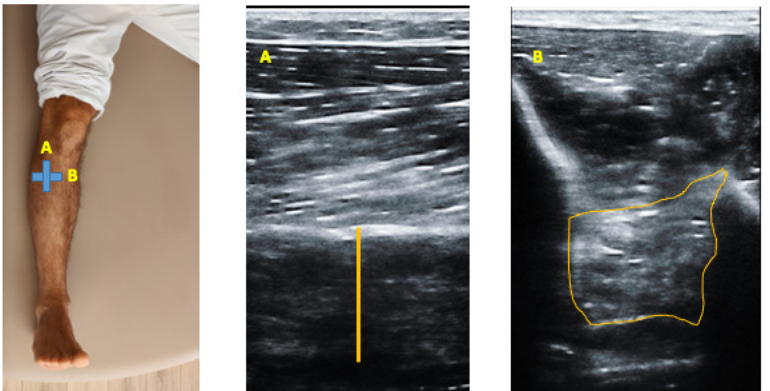
Figure 1. Ultrasound imaging thickness and CSA of the TP muscle. ( A ) Upper third of the imaginary line in a longitudinal view (thickness) and ( B ) Transversal view (CSA) to identify the TP.